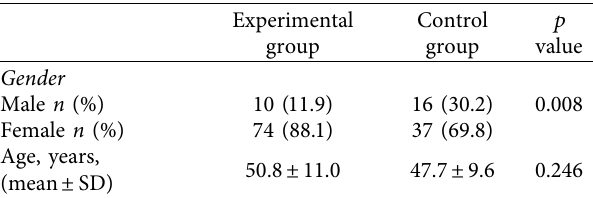
Table 2: Demographic characteristics of the experimental group and the control